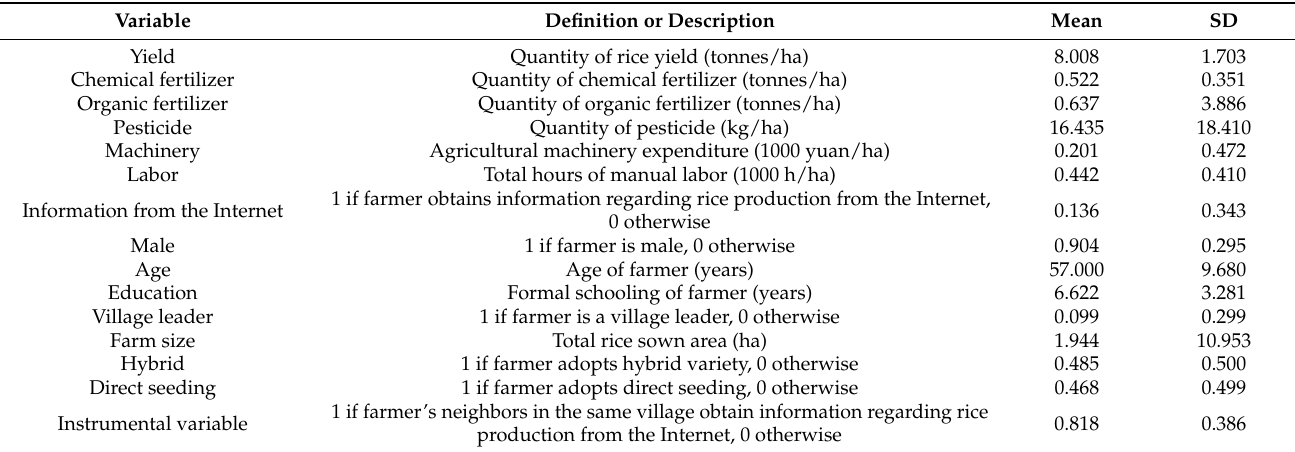
Table 1. Definition and descriptive statistics of variables.